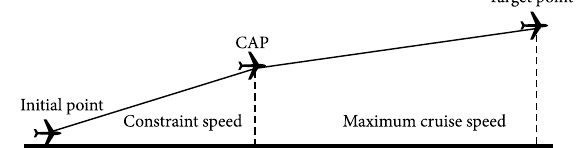
Fig. 3. Trajectory of the aircraft used to compute